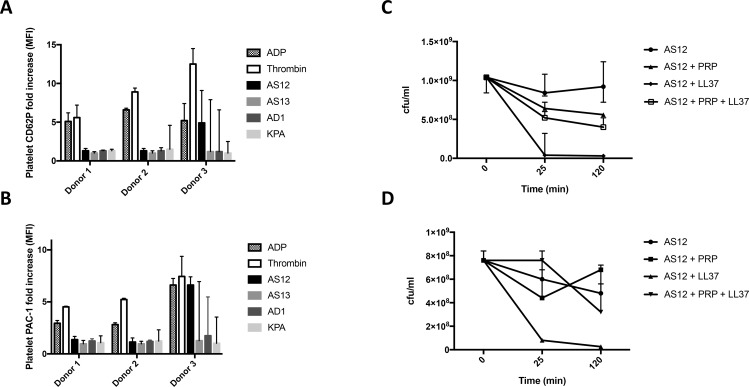
C. acnes activation of platelets is donor-dependent and does not affect bacterial viability.Platelet activation was measured by platelet surface-bound CD62P (A; FACS) and PAC-1 expression on platelets (B; FACS), in three different donors using four strains of C. acnes (AS12, AS13, AD1, KPA171202), and the difference between the donors was investigated using Kruskal Wallis (A; p = 0.0076, B; p = 0.0132). The ability of C. acnes strain AS12 to survive in the presence of PRP with or without LL37 was measured at three different time points (0, 25, and 120 minutes after mixture) after vortex (C) or combining vortex and sonication (D) before serial dilution and cfu counting. Bacterial count did not change significantly over time as assessed by Kruskal Wallis (n.s.). In all activation experiments, collagen, ADP and thrombin were used as controls where applicable, and PRP and HEPES buffer as references. All experiments were performed three independent times and presented as medians with range.